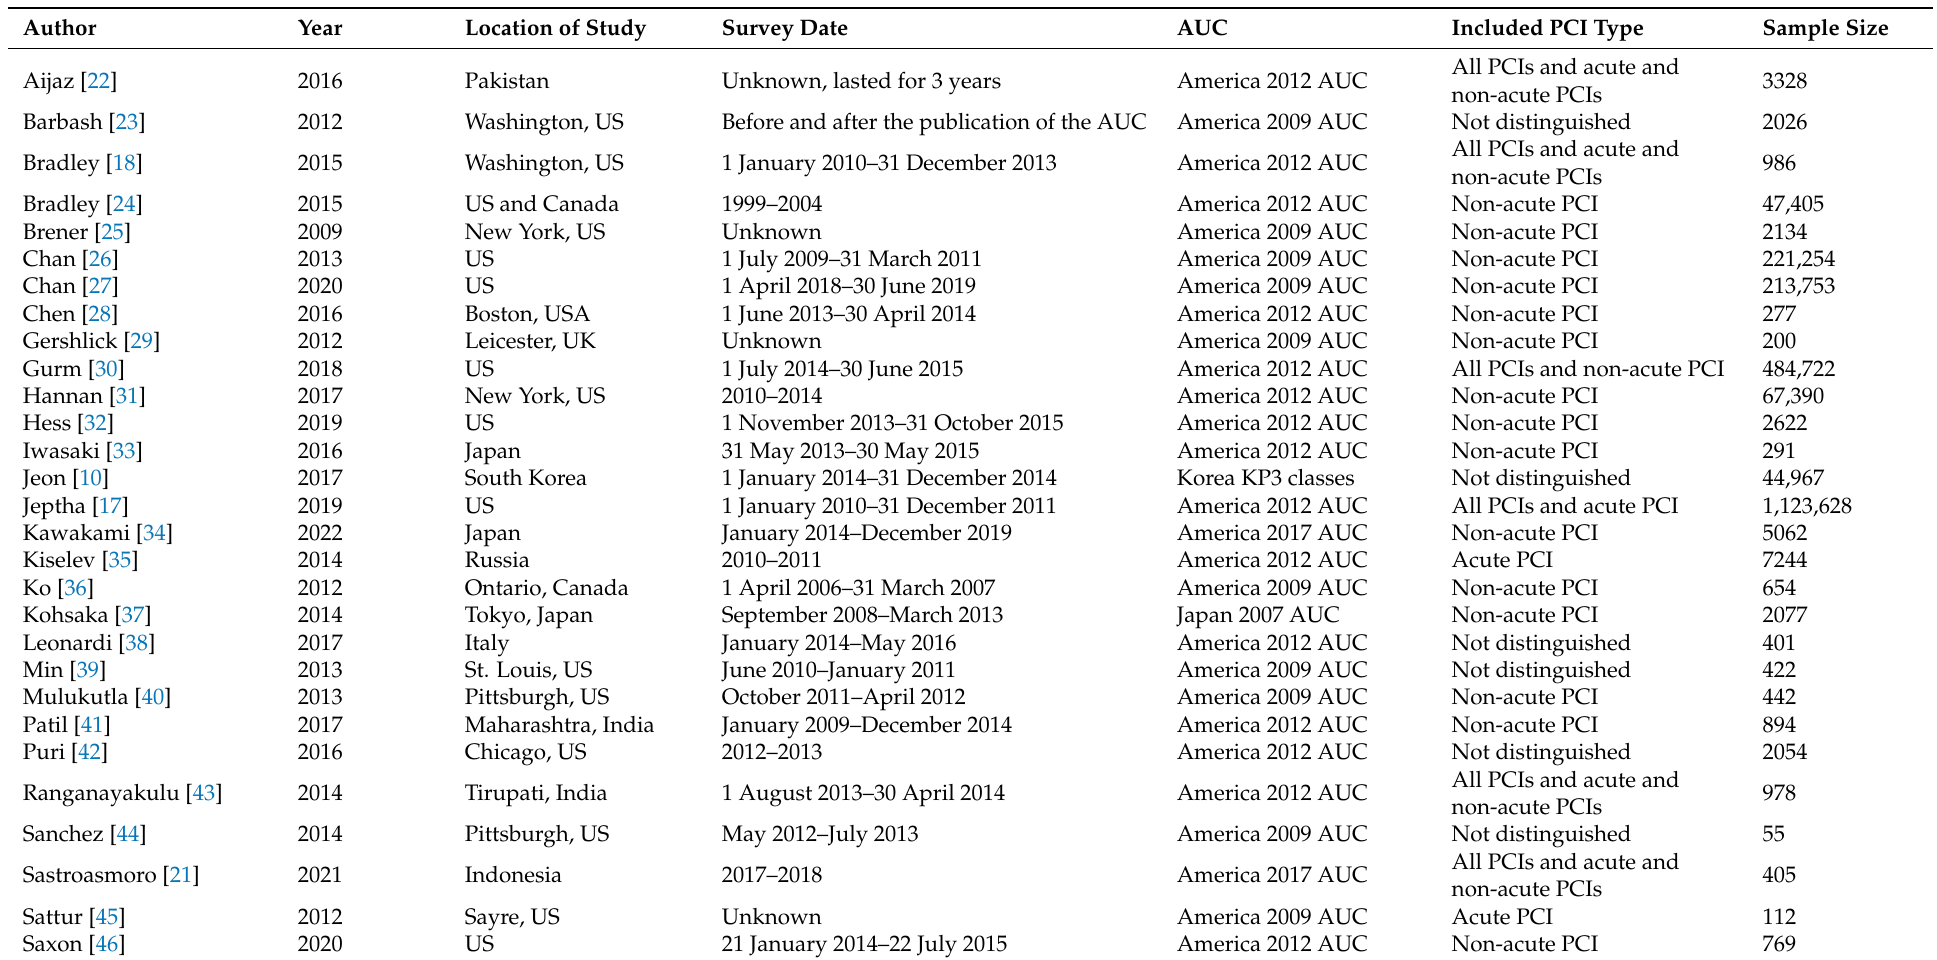
Table 1. Characteristics of the included